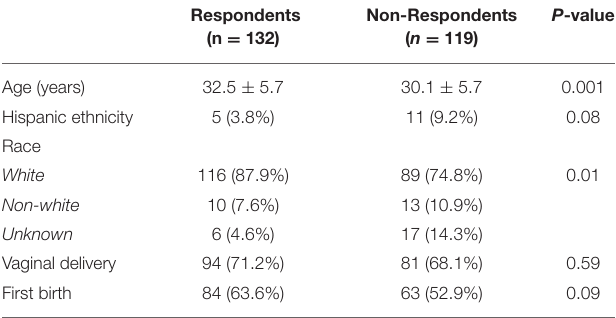
TABLE 1 | Demographic characteristic of respondents vs.